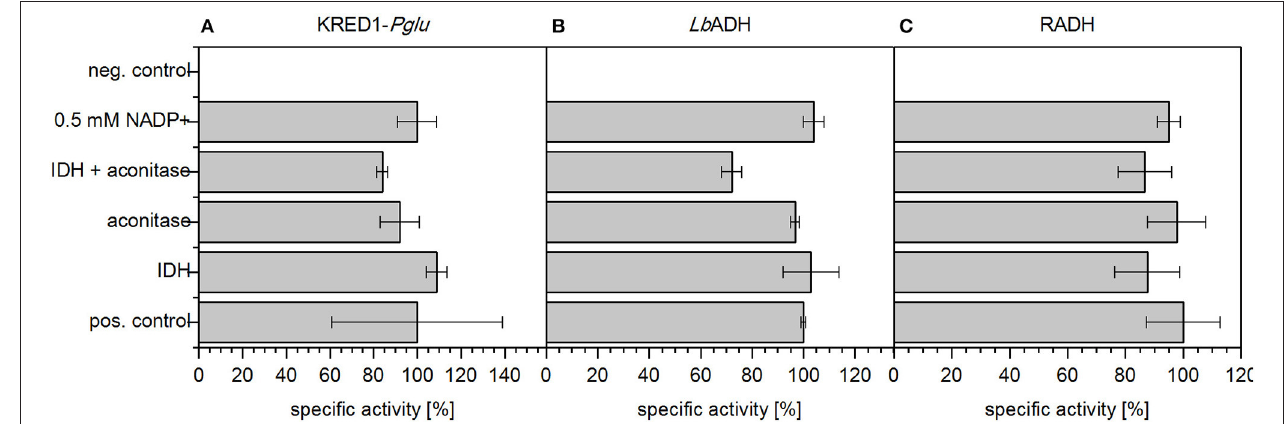
FIGURE 4 | Limitation analysis based on endogenous NADP + amounts and endogenous TCA cycle enzymes. In an applied CCE setup the reduction of acetophenone by (A) Ogataea glucozyma CBS 5766 ketoreductase 1 (KRED1- Pglu ), (B) Lactobacillus brevis alcohol dehydrogenase ( Lb ADH), and (C) Ralstonia sp. alcohol dehydrogenase (RADH) was investigated in presence of citrate. To identify a possible limitation by endogenous TCA cycle enzymes 1U mL − 1 aconitase and 1U mL − 1 isocitrate dehydrogenase (IDH) were added individually and together. Further also the possibility of limiting NADP + amounts was investigated by supplementation thereof. The negative control (neg. control) contained neither additional enzymes for cofactor regeneration nor citrate; 0.34U mg − 1 KRED1- Pglu CCE, 3.56U mg − 1 Lb ADH CCE, and 2.4U mg − 1 RADH CCE were normalized to 100% specific activity. n = 3.